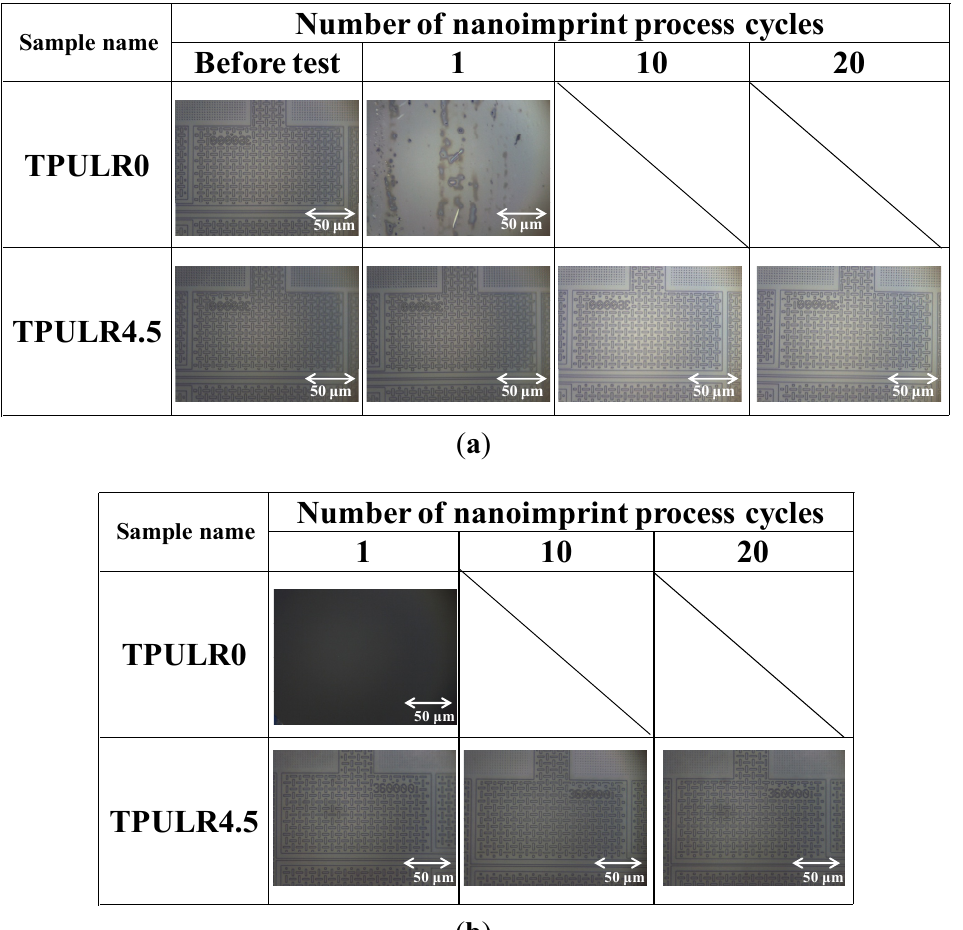
Figure 4. Optical microscope images of ( a ) template and ( b ) nanoimprint resist material on underlayer with 500 nm contact hole and 2 μ m line